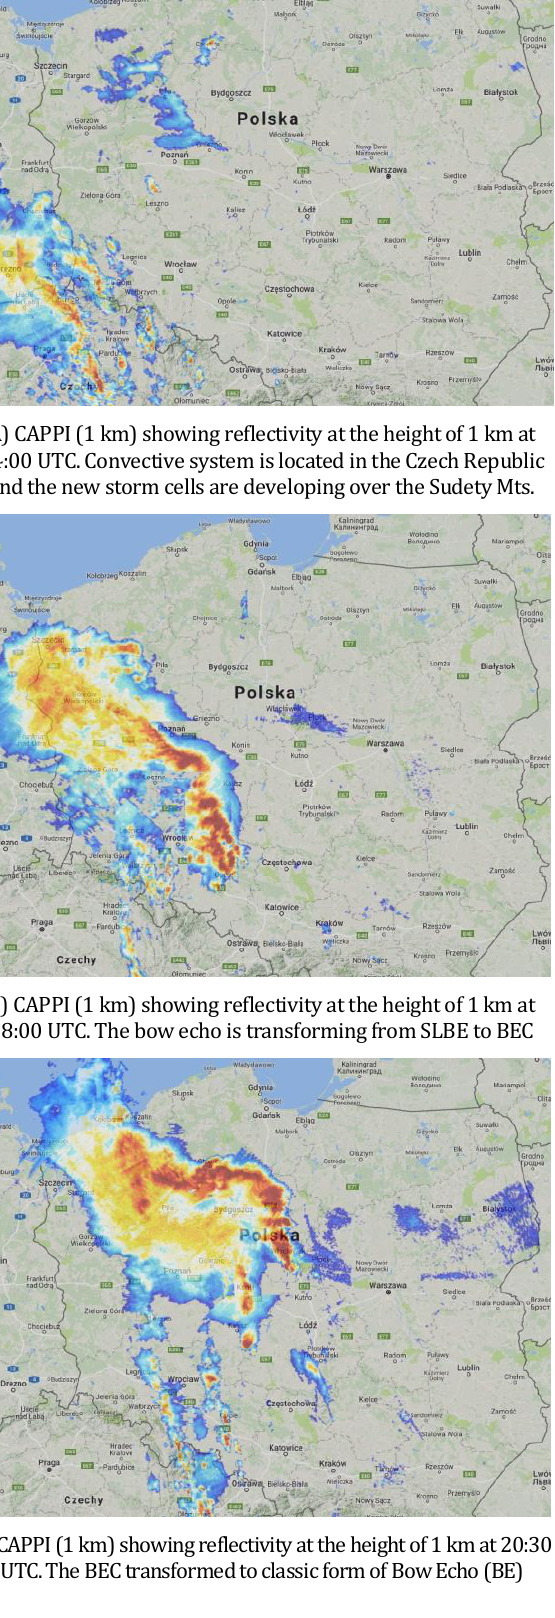
Fig. 3. Development of MCC with bow echo in Poland during the 11 August 2017 Source: IMGW-PIB via radar-opadow.pl. The data were processed. Abbreviations: SLBE - Squall Line Bow Echo, BEC – Bow Echo Complex, BE – Bow